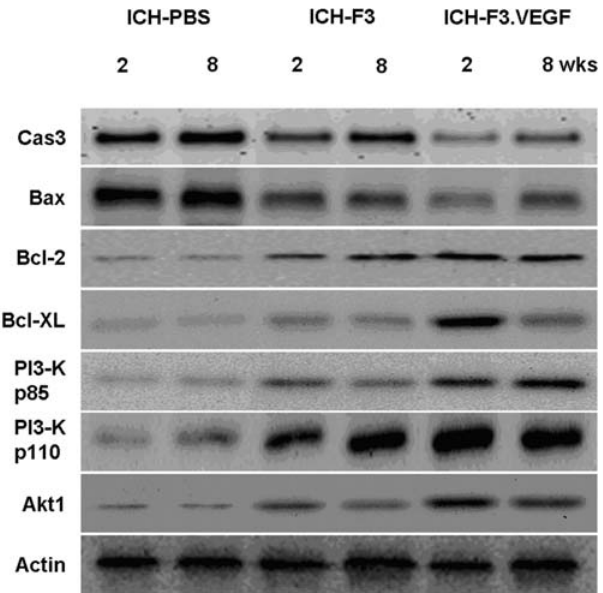
Figure 9. Western blot analysis of apoptosis-related proteins, including proapoptotic proteins, (caspase 3 and Bax), antiapoptotic proteins (Bcl- 2 and Bcl-X L ), and cell survival signal molecules (PI3-kinase p85, PI3 kinase p110 and Akt1) in ICH brains receiving transplantationof F3 and F3.VEGF human neural stem cells. A significantly decreased expression of caspase 3 and bax is found in ICH-F3.VEGF group at 2 and 8 weeks post-transplantation. In ICH animals receiving F3.VEGF grafts, the expression of antiapototic proteins and signal molecules Bcl-2, Bcl-X L , PI3-K p85, PI3-K p110 and Akt1 is markedly increased.